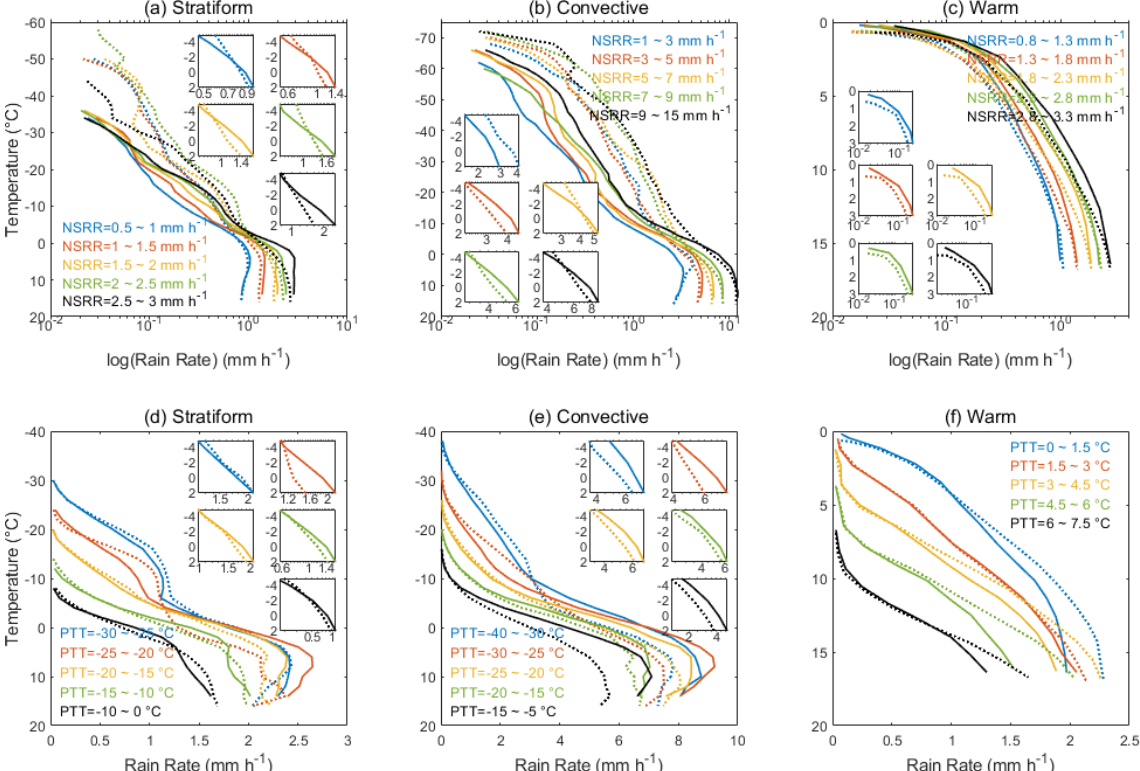
Figure 4. Differences in the vertical profiles of stratiform (a, d) , convective (b, e) , and warm (c, f) precipitation for pristine (dashed lines) and dusty (solid lines) conditions for a given NSRR (a, b, c) or PTT (d, e, f) . Different colors denote different NSRR or PTT values. Each panel focuses on the rain rate in the mixed layer (temperatures between − 5 and 2 ◦